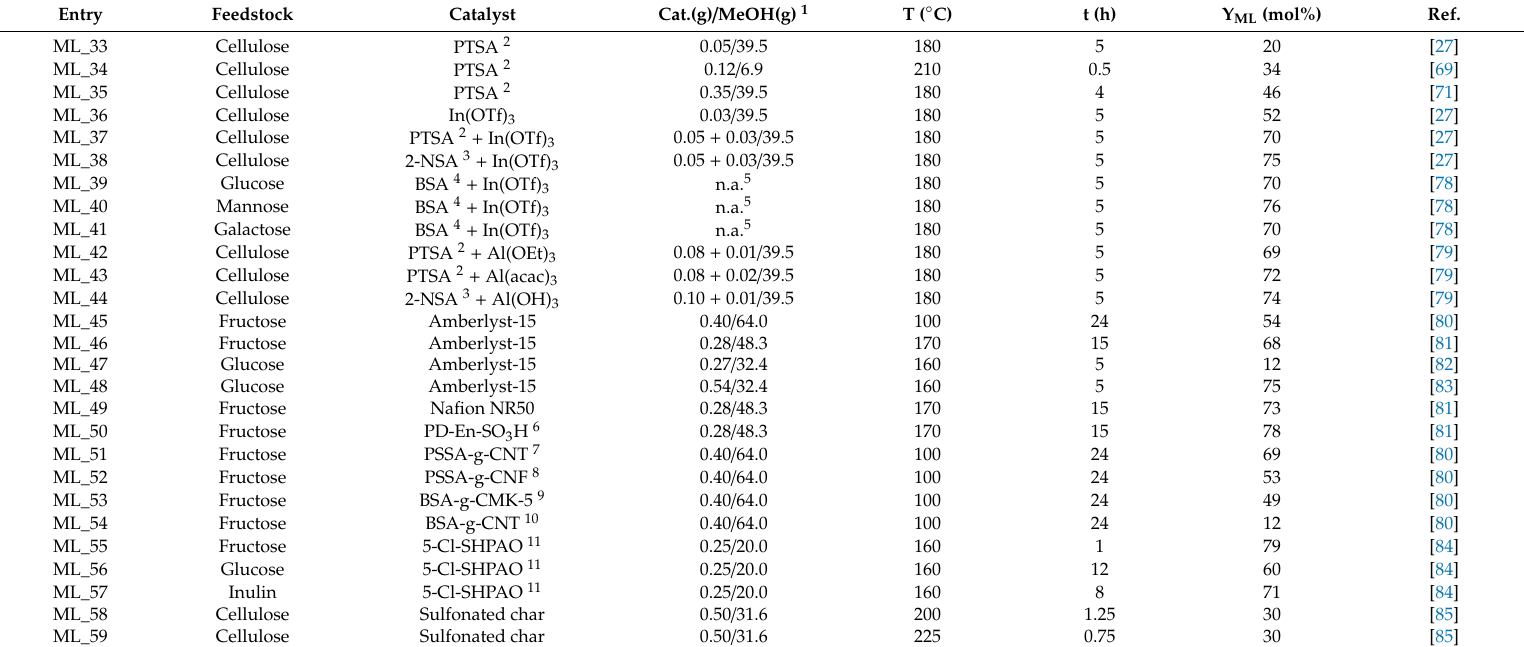
Table 2. Sulfonic acids, sulfonate salts, and their combinations for the ML production from C6 model carbohydrates, under conventional